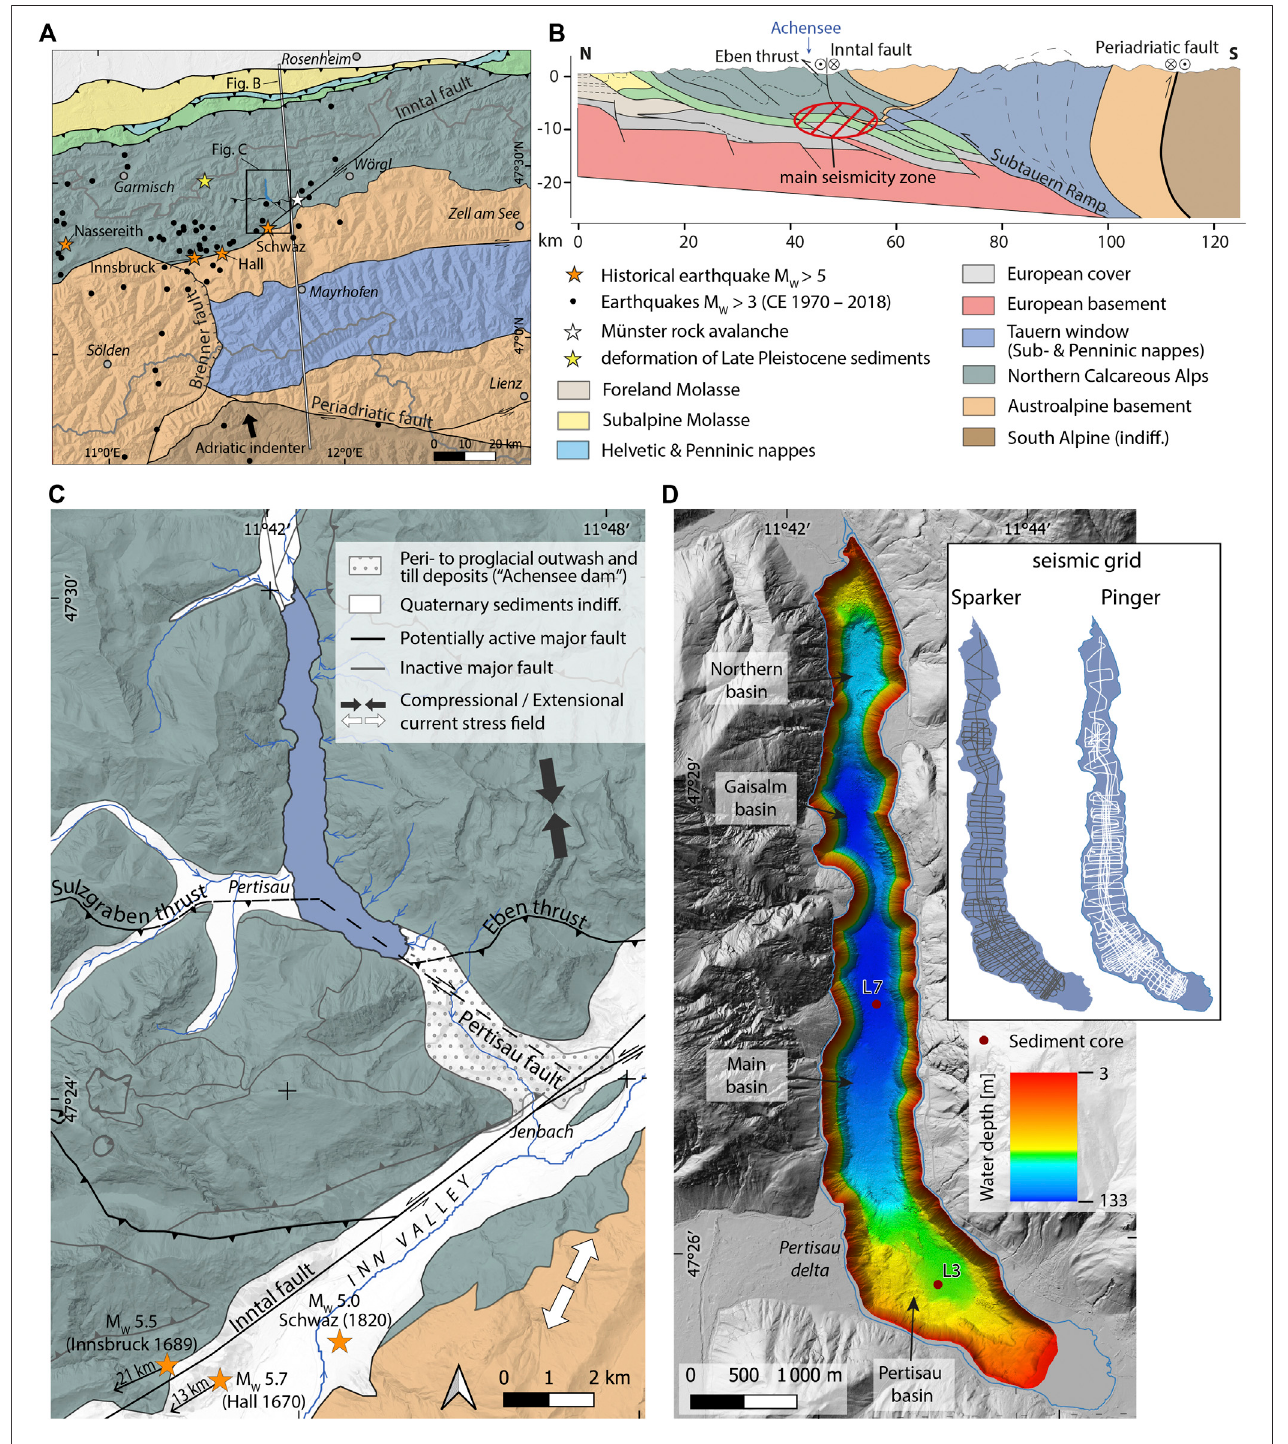
FIGURE 1 | Overview of the study area. (A) Seismotectonic map of the central Eastern Alps including the main faults and faults relevant for this study, historical (Stucchi et al., 2013) and recent earthquakes (Reiter et al., 2018), the Münster rock avalanche and deformation in Late Pleistocene sediments of hypothesized neotectonicorigin(Costantiniand Ortner, 2013).Map modi fi edafter Brandner (1980);Bousquetet al.(2012);GeologischeBundesanstalt(2021a,2021b). (B) Simpli fi ed cross section across the Eastern Alps indicating the location and depth of the main zone of current seismicity after Reiter et al. (2018) in respect to the major fault systems. Cross section modi fi ed after Ortner et al. (2006); Ortner et al. (2015); Reiter et al. (2018). (C) Geological map of the surroundings of Achensee. The lake is located within the Northern Calcareous Alps and dammed in the Southeast by proglacial outwash and till deposits accumulated before the Last Glacial Maximum. The